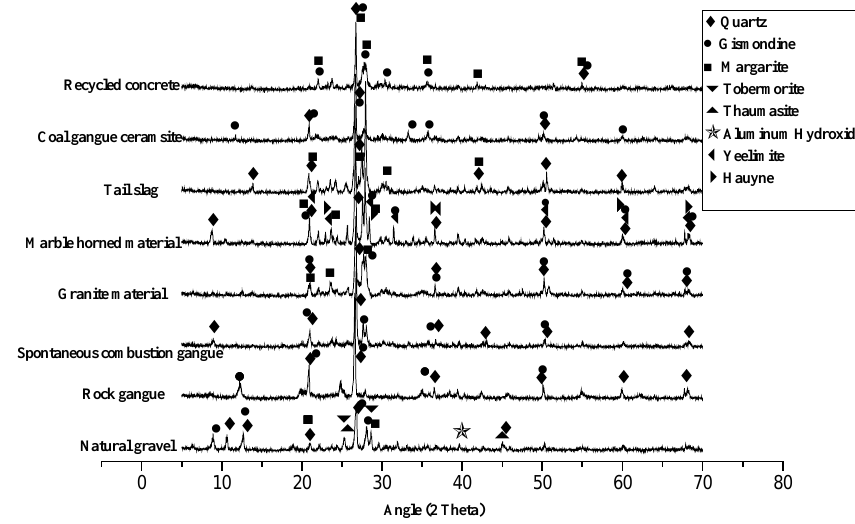
Figure 3. XRD of the different coarse aggregates.